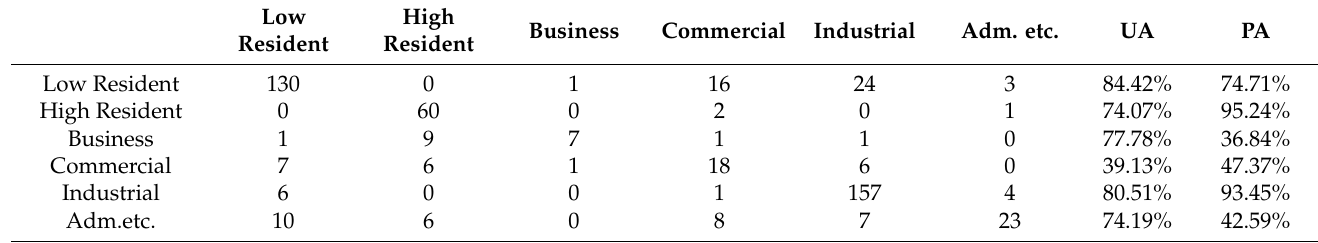
Table 5. Grid confusion matrix for Level II (2100 training & 516 testing samples).